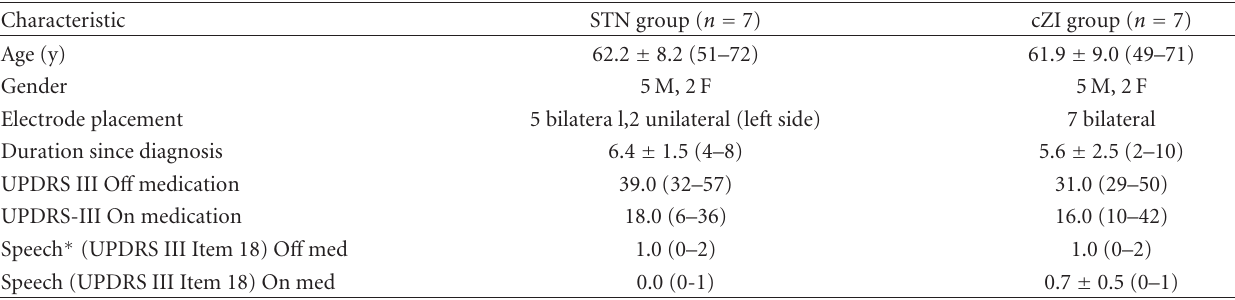
Table 1: Characteristics of patients in the two surgical groups. Mean age as well as median unified Parkinson’s disease rating scale smotor scores, UPDRS-III, (with standard deviations) are provided. There were no statistical di ff erences between the groups for age, duration since diagnosis, or any of the UPDRS-III